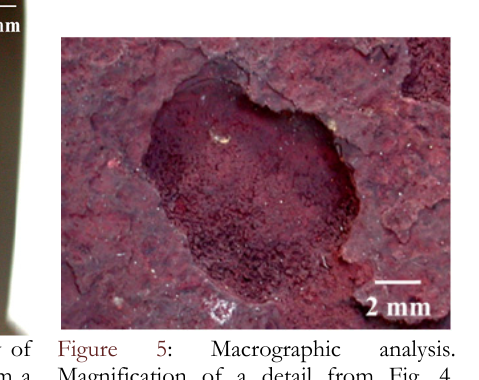
Figure 5: Macrographic analysis. Magnification of a detail from Fig. 4. Pitting corrosion.